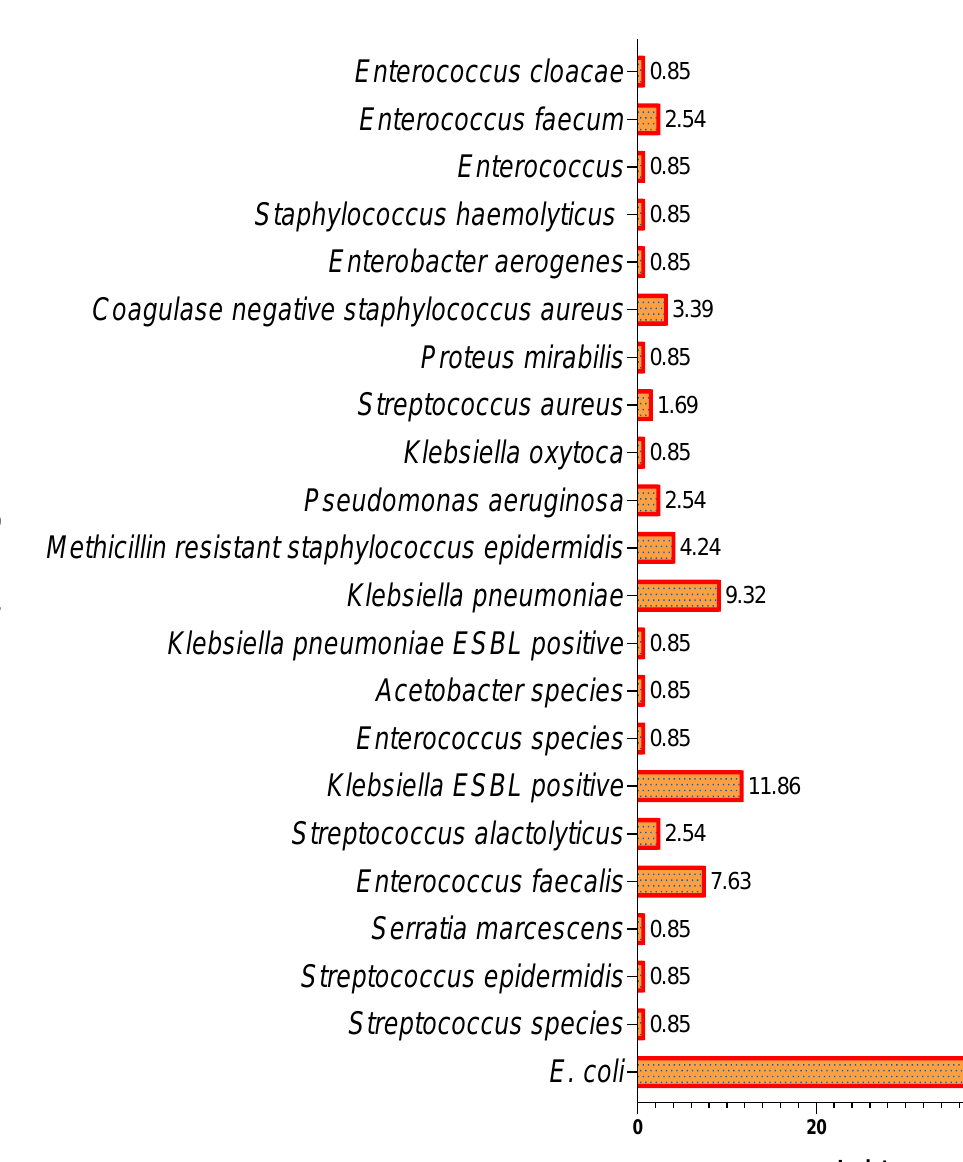
4 of 12 Table 1. Demographic data of pediatric study population. Variables